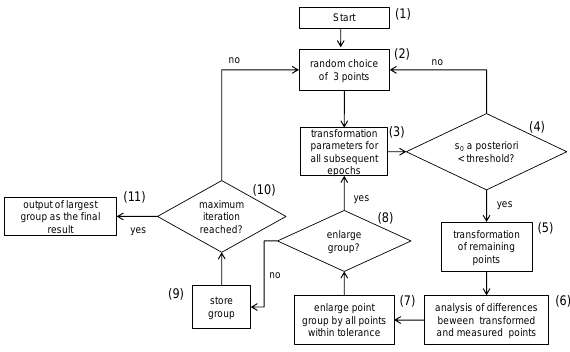
Figure 3. Process of congruence analysis